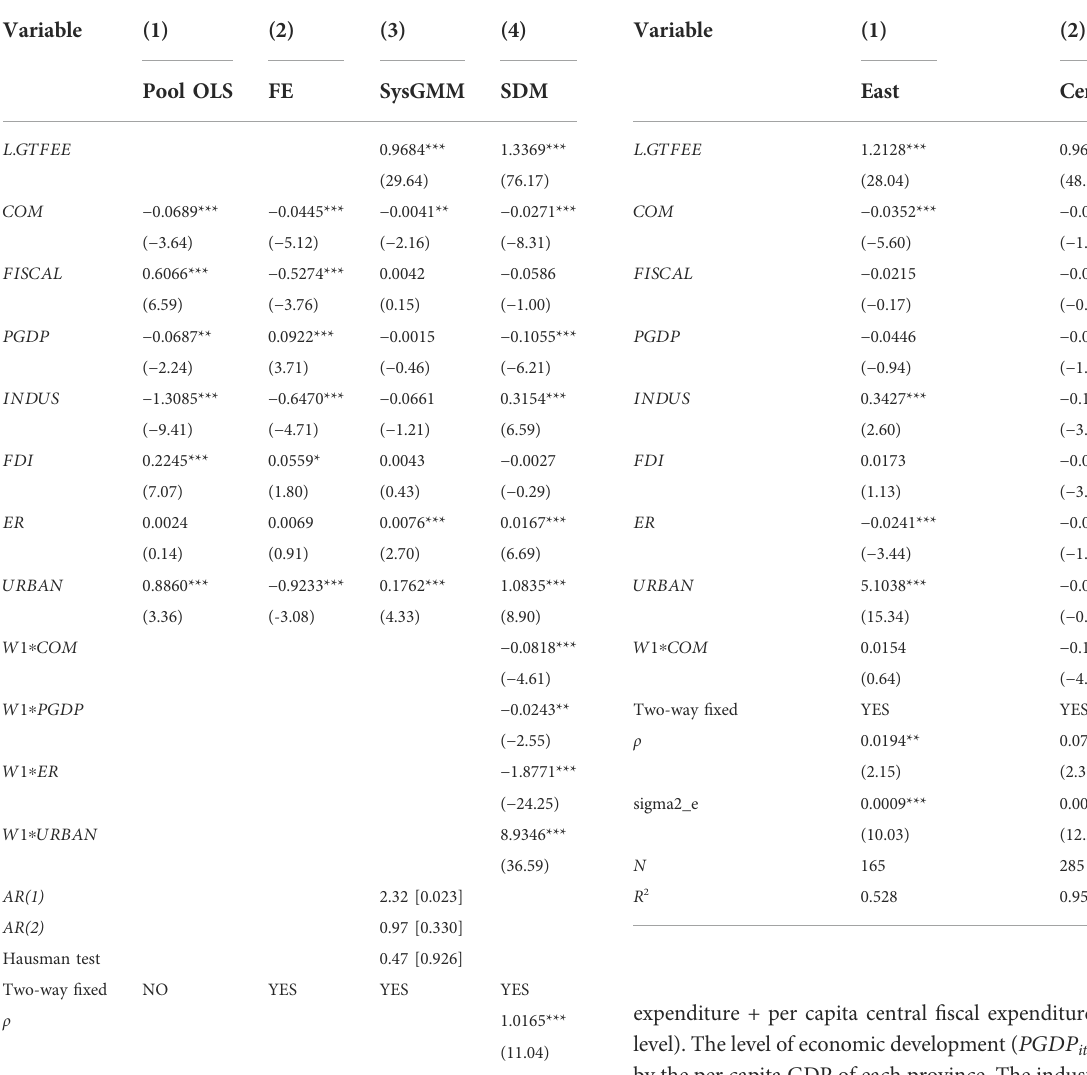
TABLE 4 Benchmark regression. TABLE 5 Regional